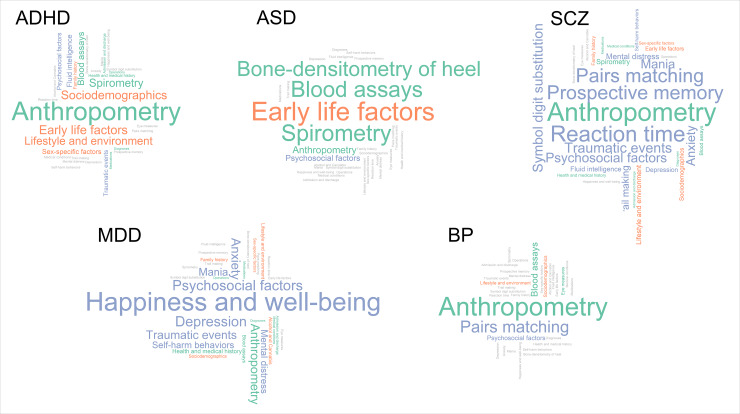
Categories of highly associated outcomes with polygenic risk scores for attention deficit/hyperactivity disorder (ADHD), autism spectrum disorder (ASD), schizophrenia (SCZ), major depressive disorder (MDD) and bipolar disorder (BP).Size of categories depends on the relative number of associated outcomes to the total number of outcomes within each category. Only categories with more than 1 variable are shown. Lifestyle and socio-demographic factors are shown in orange, physical health measures are shown in green and mental health, brain and cognition traits are shown in violet. Grey categories had zero hits for the corresponding disorder.